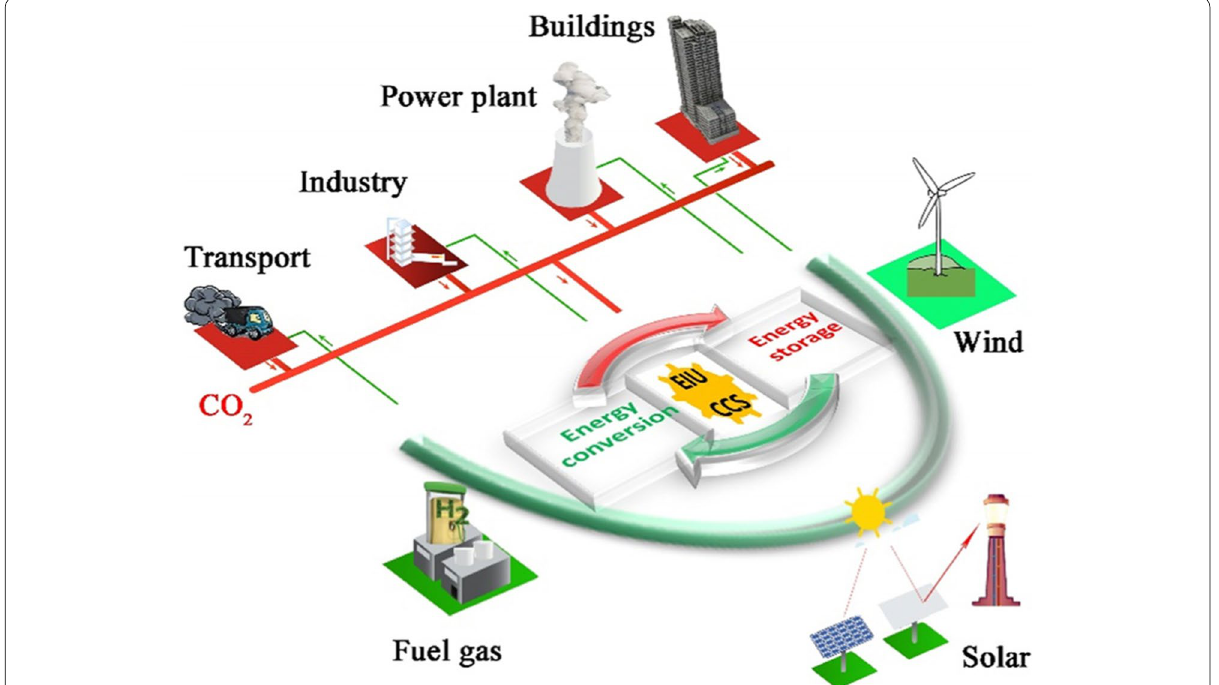
Fig. 3 Schematic illustration of energy conversion and storage strategy for carbon-neutral and its potential applications